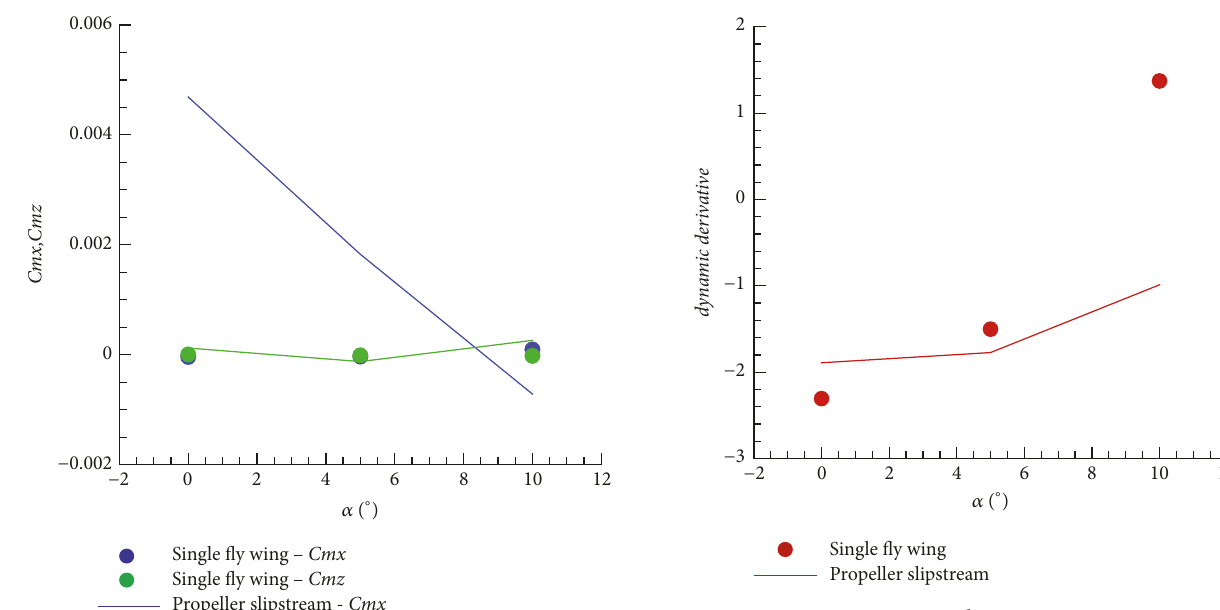
Figure 22: Dynamic derivatives 𝐶 𝑚 ̇𝛼 + 𝐶 𝑚𝑞